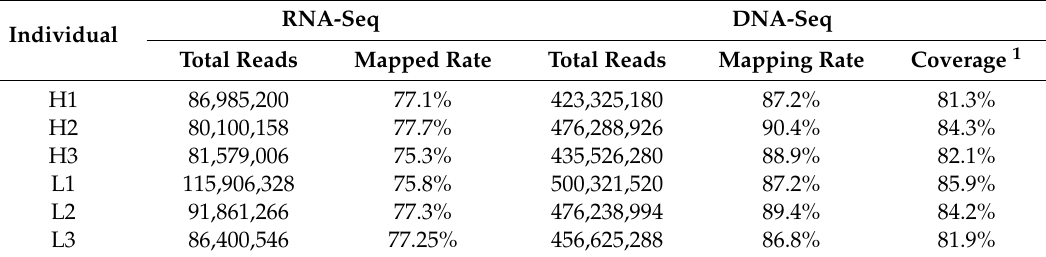
Table 2. Summary of the high-throughput sequencing.